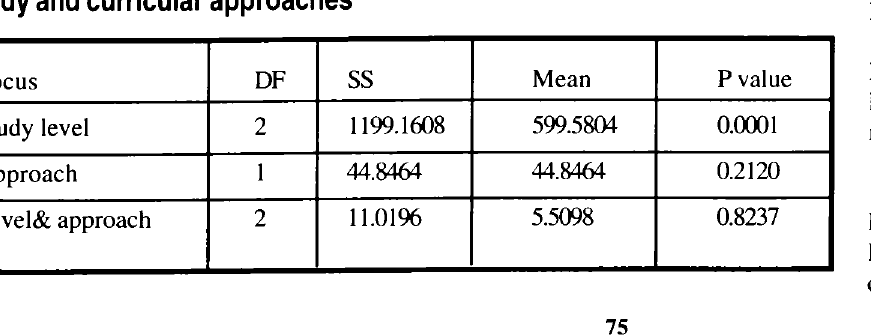
Table 5: ANOVA results on differences in total mean scores by levels of study and curricular